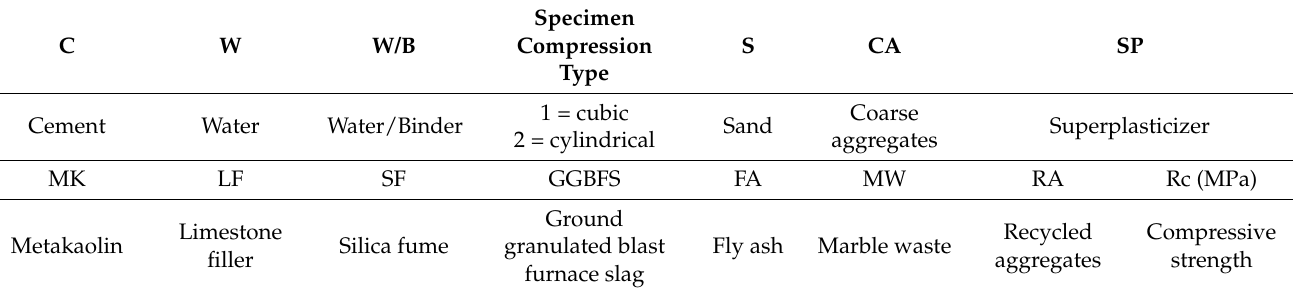
Table 2. Data notation and abbreviations.